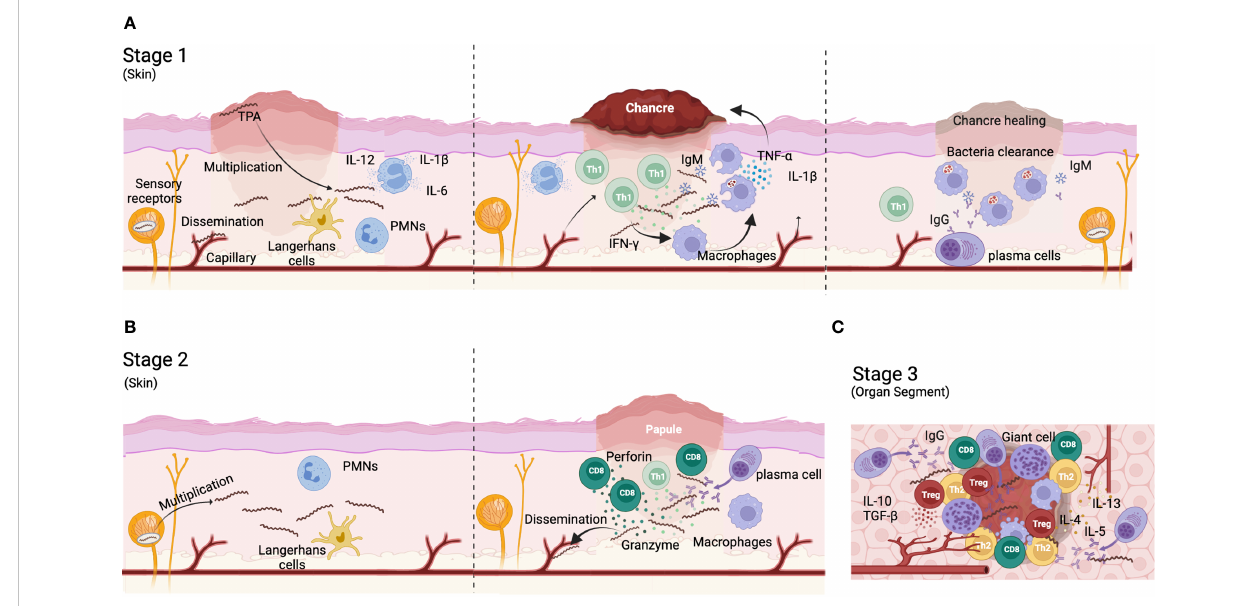
FIGURE 1 Immune response to TPA infection. (A) During primary syphilis, a local lesion called chancre appear in the site of infection. After bacteria entry, the microorganisms proliferate and disseminate to distal organs. Bacteria are phagocyted by polymorphonuclear cells (PMN) and dendritic cells that migrate to draining lymph nodes to activate CD4 + Th cells. Th1 T cells migrate to the bacteria proliferation foci and produce Th1 cytokines (IFN- g ) for recruiting and activate macrophages. M1 macrophages phagocyte bacteria and produce TNF- a and IL-1 b that contribute to chancre development and eventually necrosis. IgM antibodies and complement contribute to bacteria opsonization favoring their removal by macrophages. (B) During secondary syphilis, TPA expands from reservoirs with systematic affectation. A typical rash appears in most cases. Anti-TPA humoral responses are mainly IgGs and plasma cells are visible in the in fi ltrate of secondary cutaneous lesions. CD8 + T-cells are more represented than CD4 + T-cells in lesion in fi ltrates. (C) Tertiary syphilis affects deep organs like brain and heart. A Th1/Th2 switch progressively occur and the immune response is down regulated by the presence of regulatory T cells. Plasma cells are well represented. Gummas can be developed in different locations (i.e., liver, skin, brain). Gummas are a granuloma-like structure characterized by a necrotic hyaline nucleus surrounded by immune cells (i.e. plasma cells, macrophages and giant cells) and fi